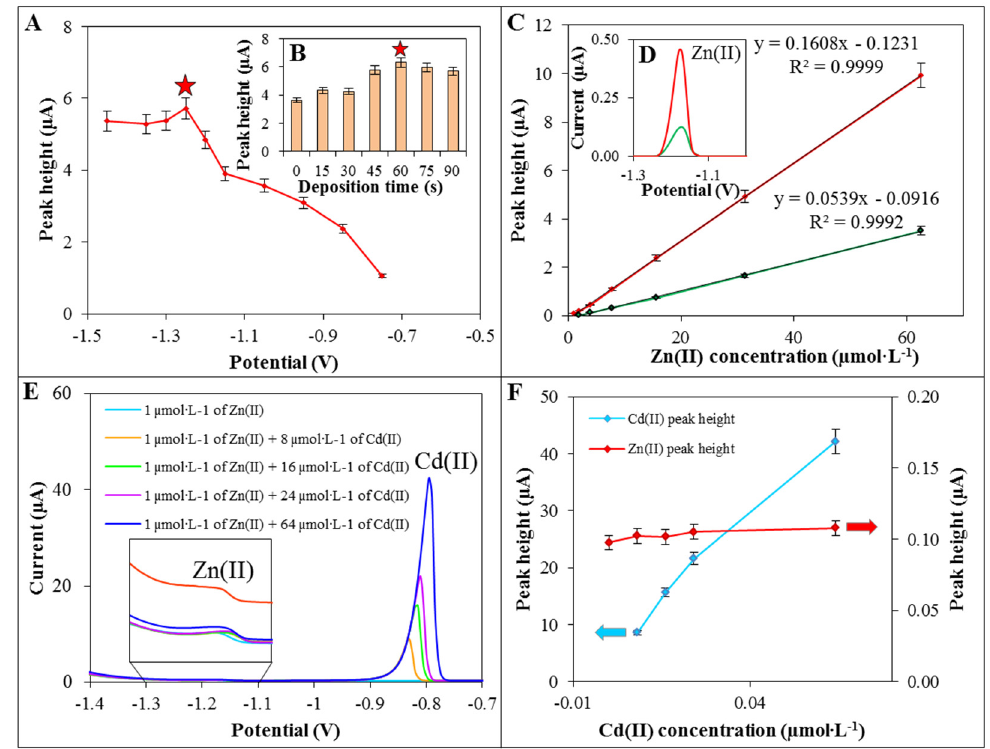
Figure 3. Dependence of Zn(II) reduction signal on deposition potential ( A ) and deposition time ( B ) of Zn(II) (35 μ mol ∙ L − 1 ) on GCE/ERGO (parameters marked with star was selected as an